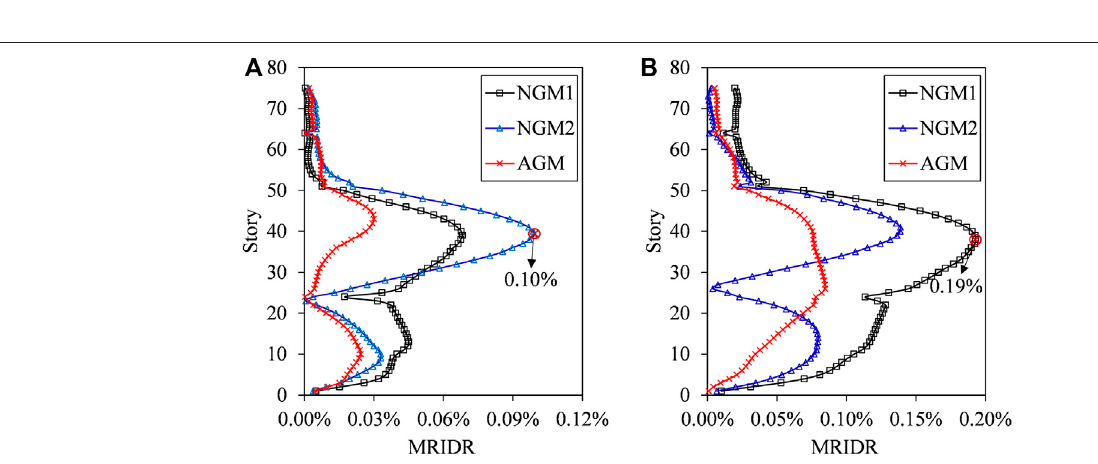
FIGURE 7 | Distribution of MRIDR. (A) MRIDR under PGA = 400 cm/s 2 . (B) MRIDR under PGA = 510 cm/s 2 .